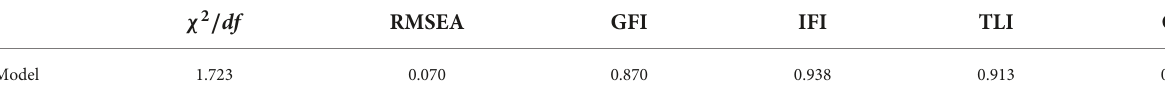
TABLE 2 Scale validation factor analysis model